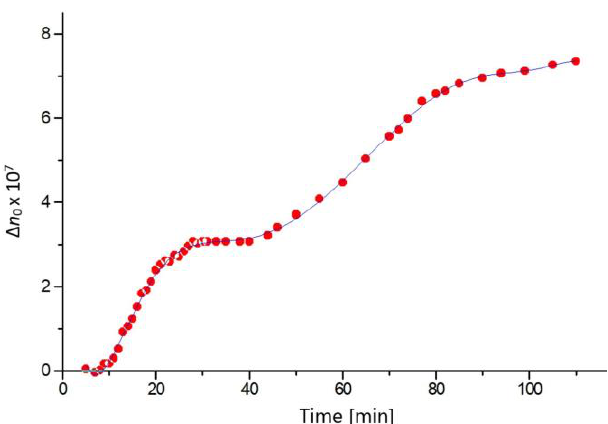
Figure 5. Time dependence of the growth of the spontaneous optical anisotropy Δ n 0 at λ 0 = 650 nm in 0.6% pure agarose gel.